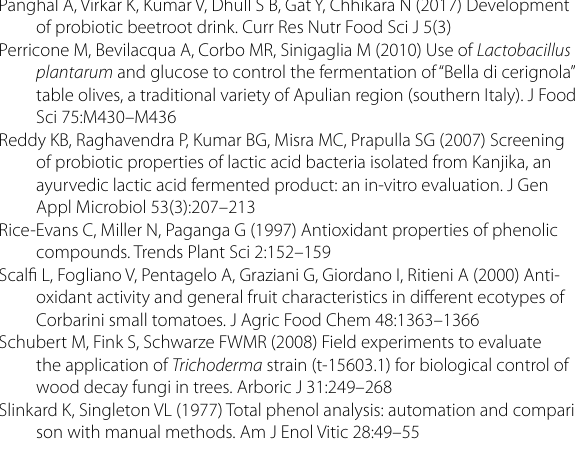
table olives, a traditional variety of Apulian region (southern Italy). J Food Sci